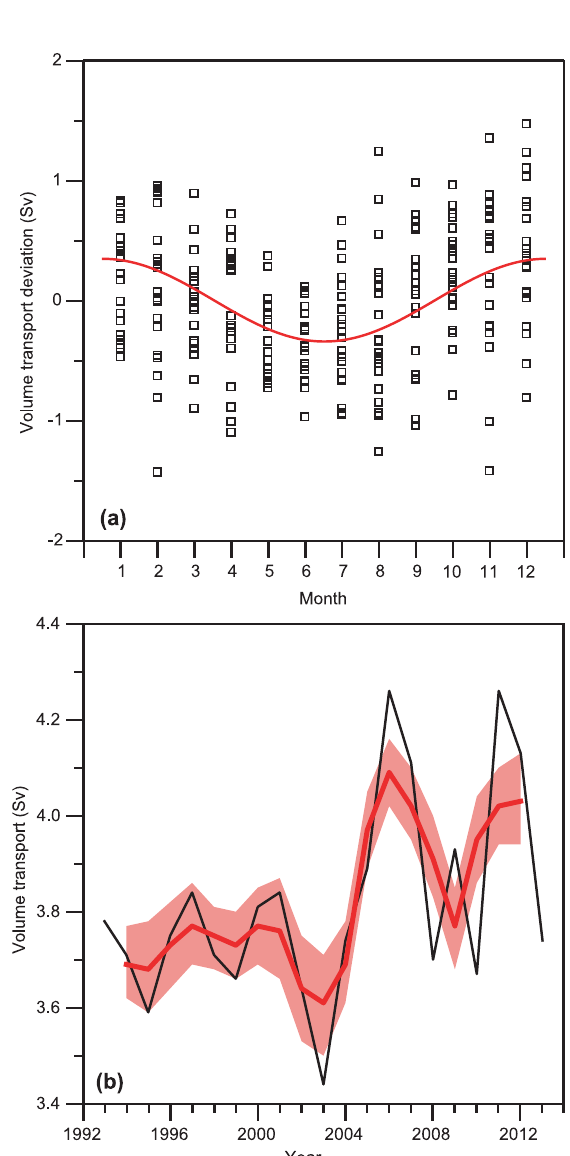
Figure 8. Seasonal (a) and interannual (b) variations of Atlantic wa- ter volume transport 1993–2013. (a) Each square represents trans- port deviation from the 3-year running mean for 1month. The red curve represents the iteratively determined sinusoidal seasonal fit (Appendix B in the Supplement). (b) Annually averaged transport (black curve) and 3-year averaged transport (red curve) with the red background representing ± one standard error over each 3-year pe-